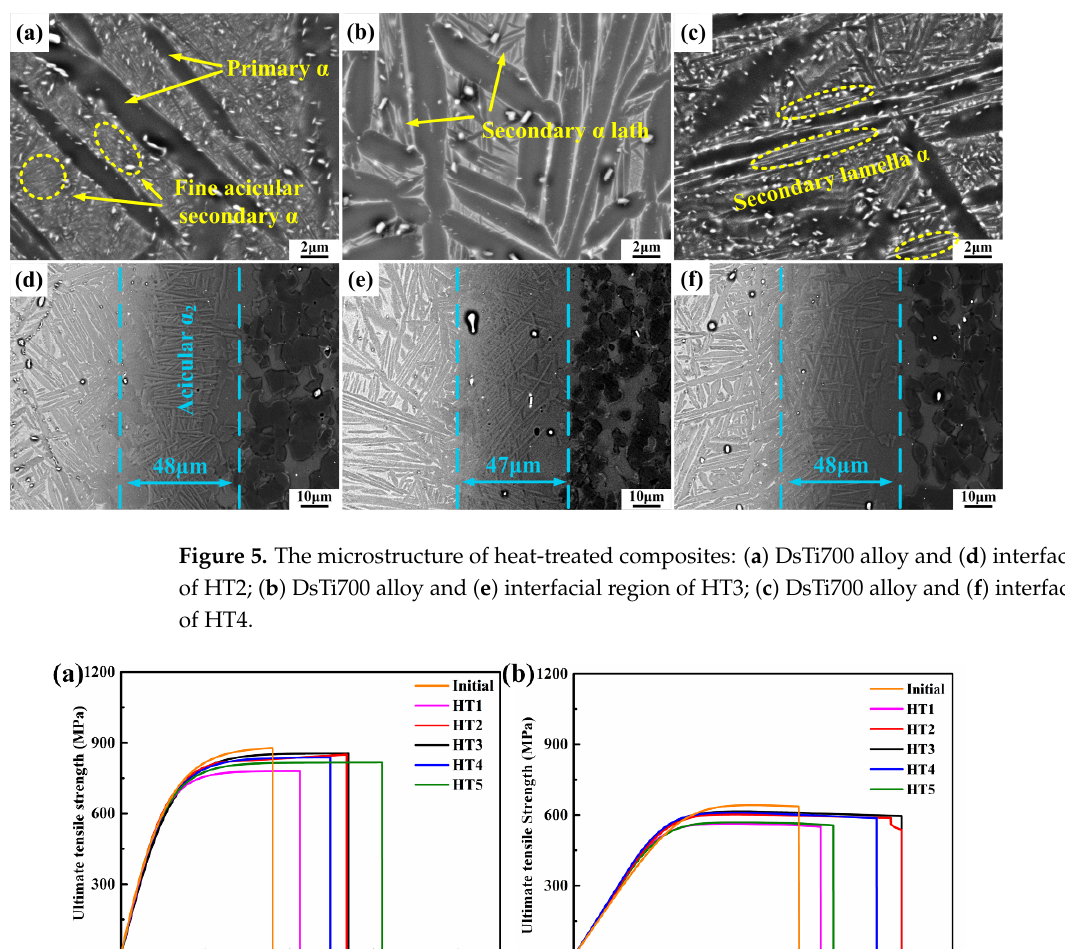
Figure 5. The microstructure of heat-treated composites: ( a ) DsTi700 alloy and ( d ) interfacial region of HT2; ( b ) DsTi700 alloy and ( e ) interfacial region of HT3; ( c ) DsTi700 alloy and ( f ) interfacial region of HT4.